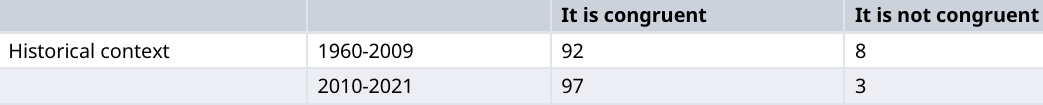
Table4.CongruencebetweenhistoricalcontextandthetreatmentoftheLGTBcommunityinadvertising(%). It is congruent It is not